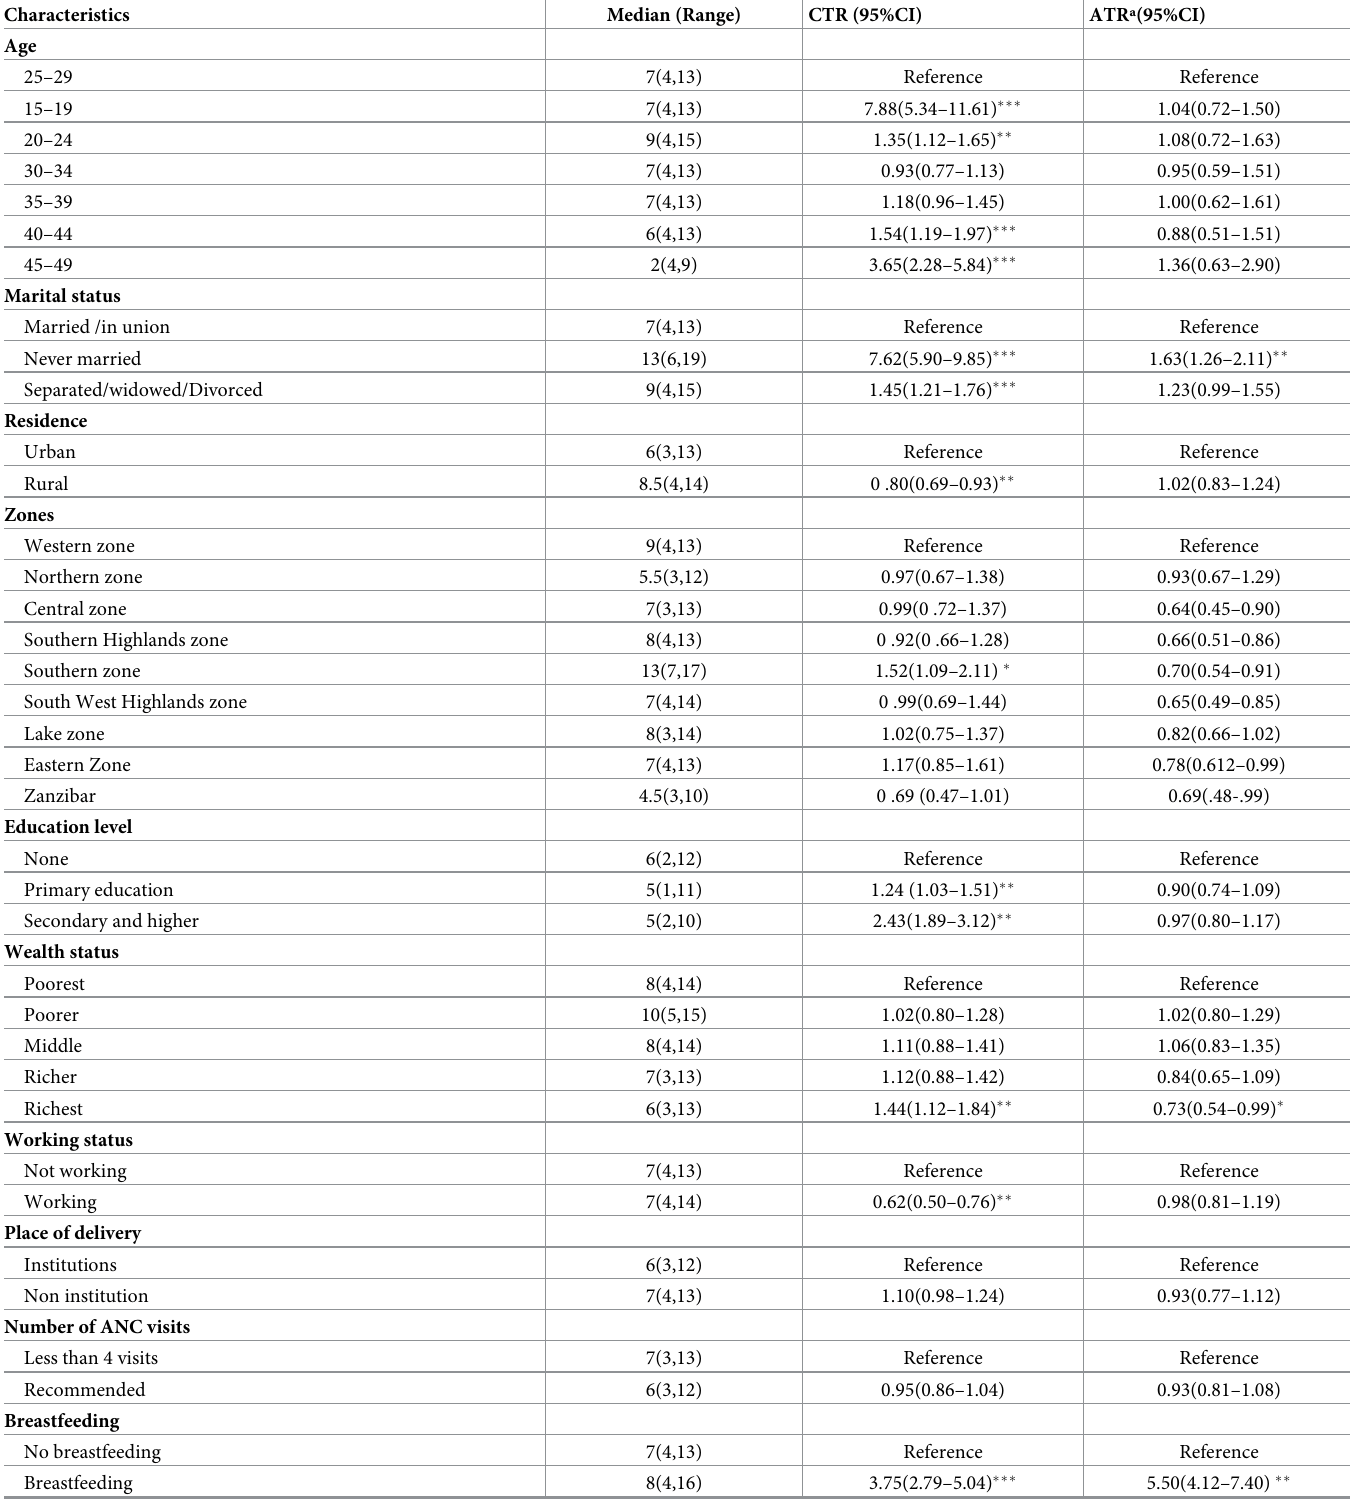
Table 3. Predictors of time to initiate modern contraceptive use after birth Weibull